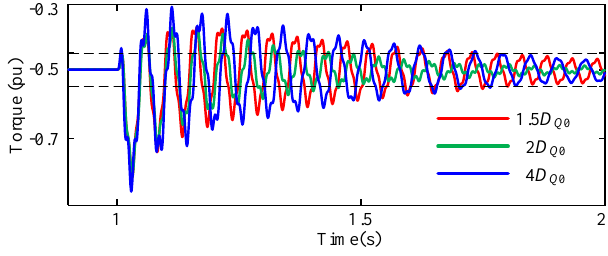
Figure 17. Waveform of electromagnetic torque.